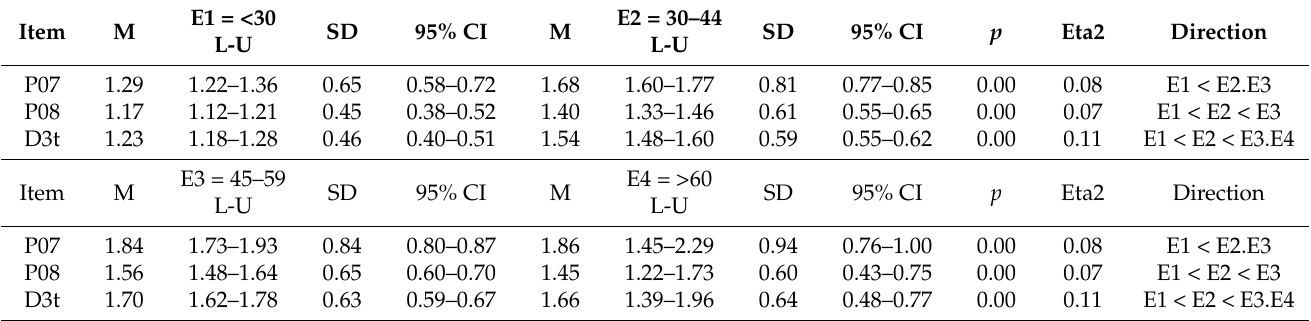
Table 6. ANOVA for independent samples by age group for dimension D3.